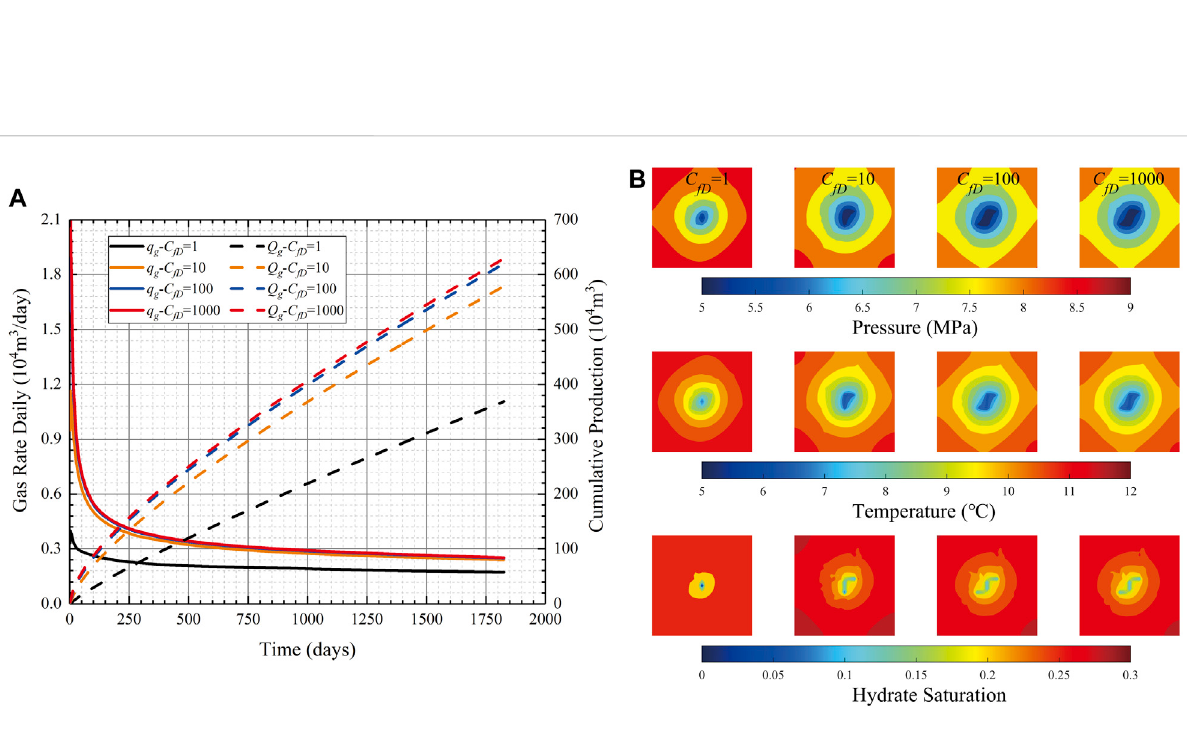
Simulation outputs of different scenarios with different values of hydraulic fracture conductivity: (A) Comparison of the production rates (B) pressure, temperature, and hydrate saturation fi eld maps at the 1800th production